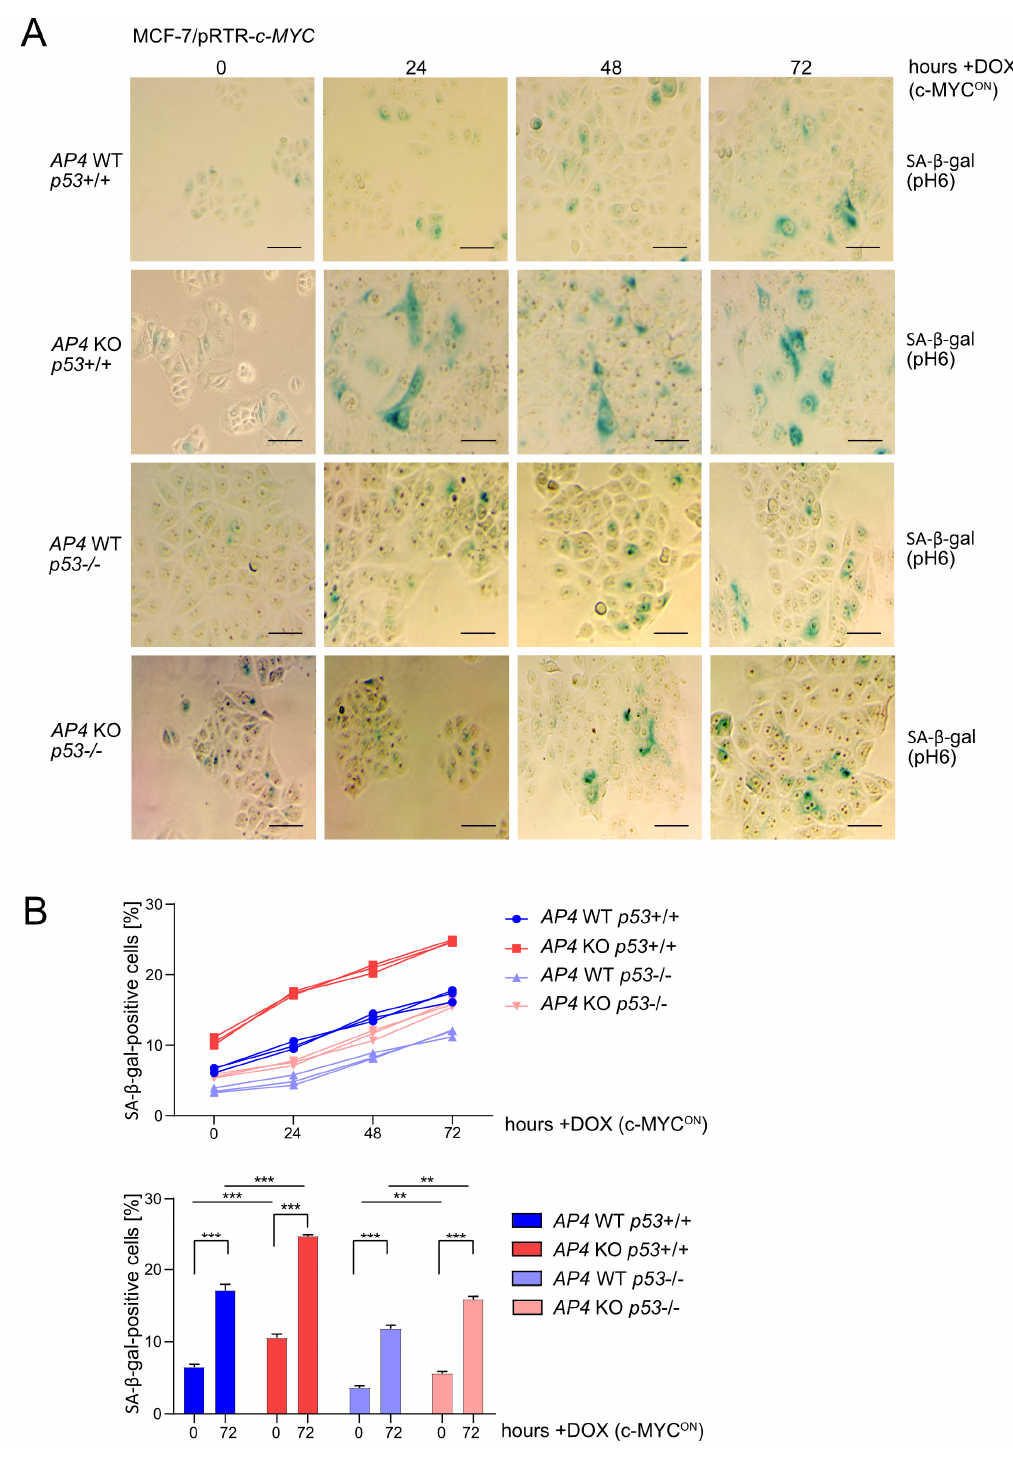
Figure 3. Effects of AP4 and/or p53 inactivation on basal and c-MYC-induced senescence. ( A ) Detec- tion of basal (no DOX treatment) and c-MYC-induced (24, 48, and 72 h DOX treatment) senescence by β -gal detection at pH 6. Scale bars: 100 μ m. ( B ) Quantification of β -gal detection as shown in ( A ). Three microscopic fields with 120 cells in total were evaluated. Results are presented as the mean +/ − SD with **: p < 0.01, ***: p < 0.001.